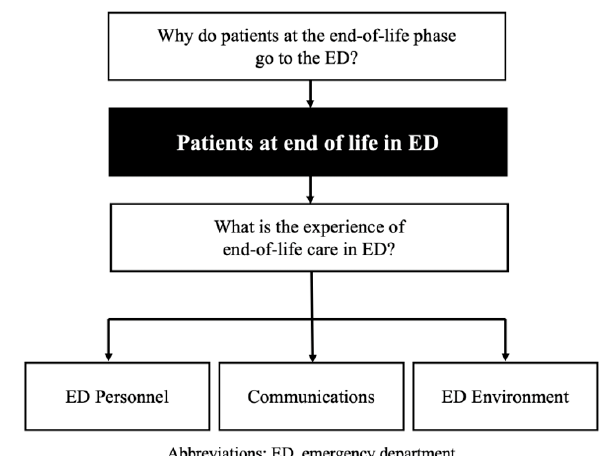
Figure 2. Coding frame.